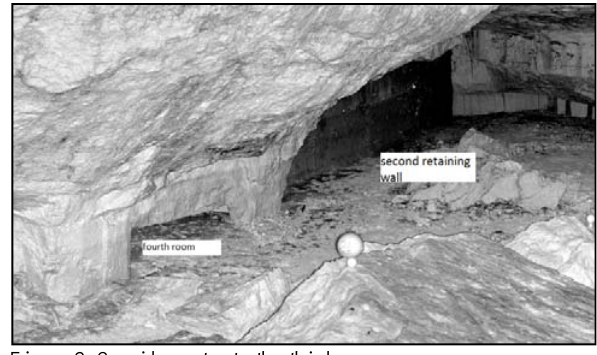
Figure 2. Corridor entry to the third